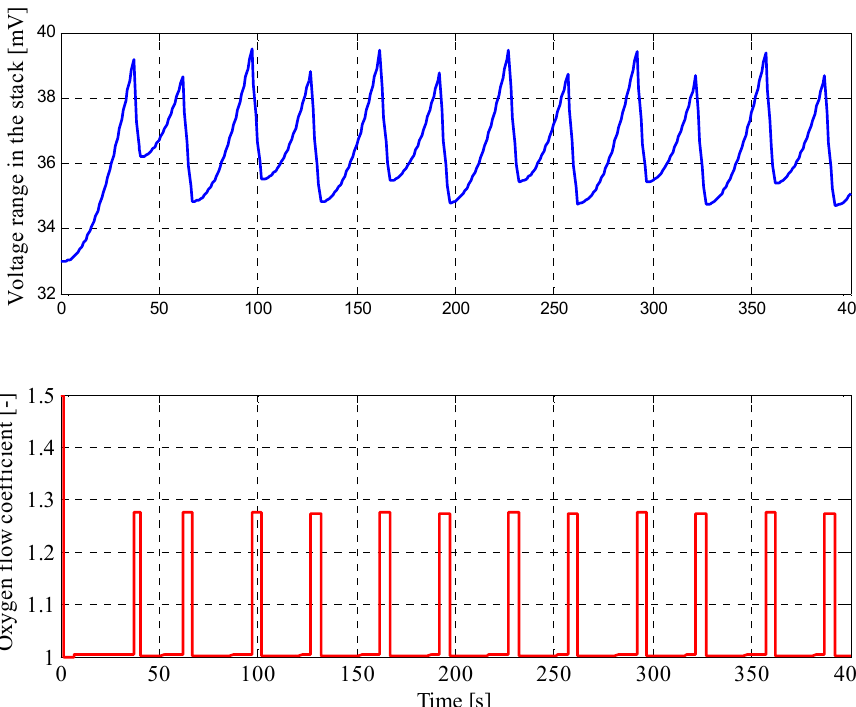
Figure 18. Voltage range and oxygen flow coefficient for the optimized by the GA fuzzy control procedure with simulation parameters set to R U , z = 38 mV and ∆ t = 5 s (initial R U = 33 ( mV ) , = 1.5 ). k O 2